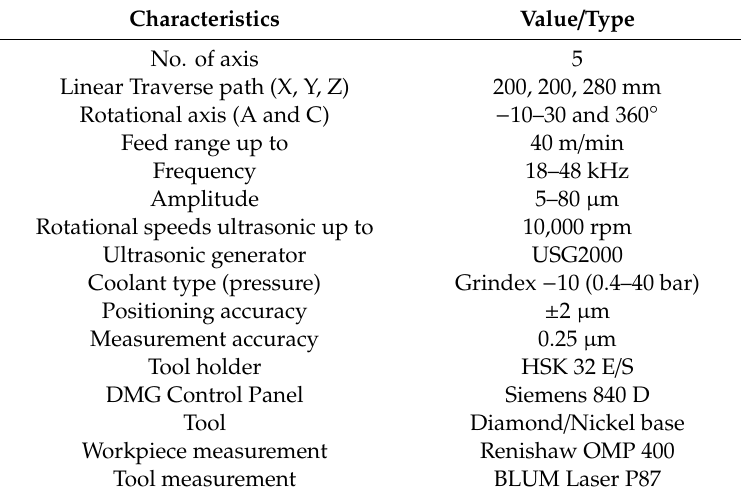
Table 1. Rotary ultrasonic machining (RUM)